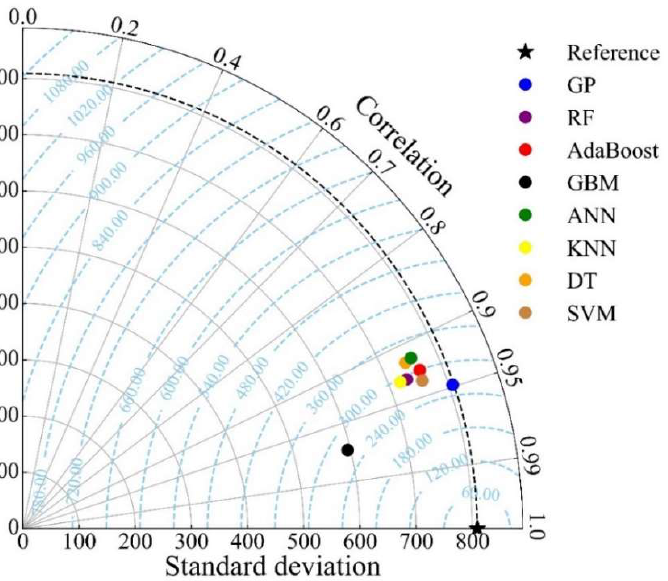
Figure 11. Taylor diagram of training set (RF: random forest, ANN: artificial neural network, DT: decision tree, SVM: support vector machine, KNN: k-nearest neighbors, GBM: gradient boosting machine, AdaBoost: adaptive boosting machine).